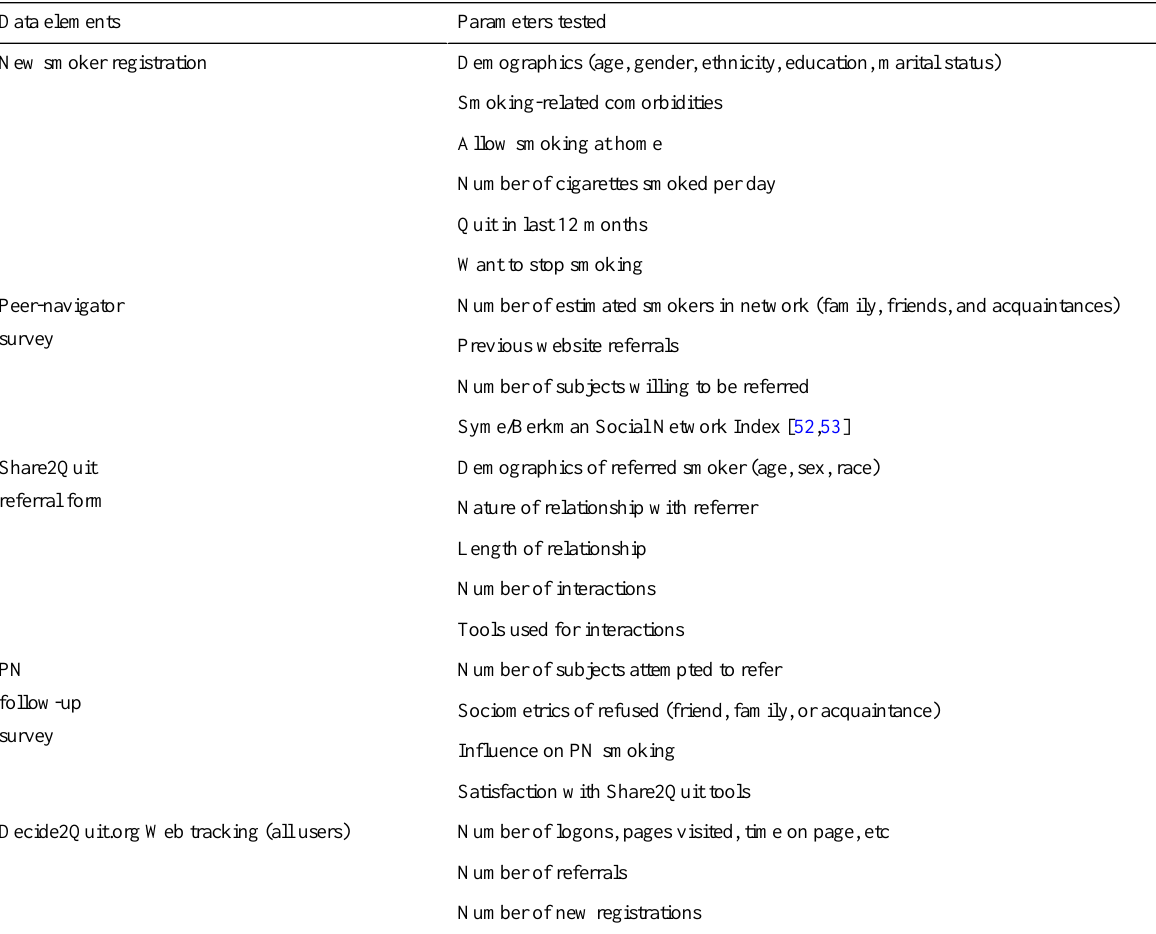
Table 1. Key data elements.